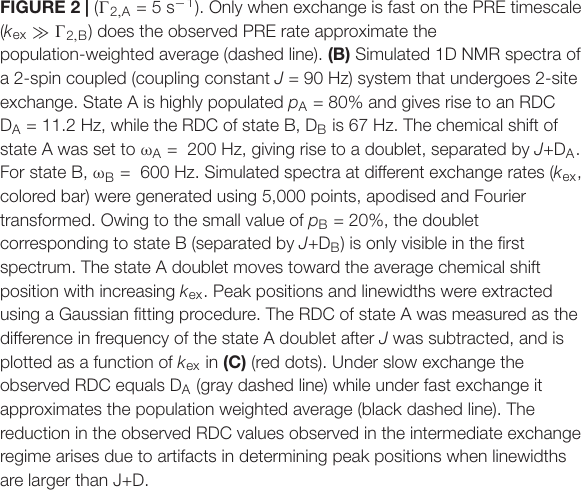
FIGURE 2 | ( (cid:48) 2 , A = 5 s − 1 ). Only when exchange is fast on the PRE timescale ( k ex (cid:29) (cid:48) 2 , B ) does the observed PRE rate approximate the population-weighted average (dashed line). (B) Simulated 1D NMR spectra of a 2-spin coupled (coupling constant J = 90 Hz) system that undergoes 2-site exchange. State A is highly populated p A = 80% and gives rise to an RDC D A = 11.2 Hz, while the RDC of state B, D B is 67 Hz. The chemical shift of state A was set to ω A = 200 Hz, giving rise to a doublet, separated by J +D A . For state B, ω B = 600 Hz. Simulated spectra at different exchange rates ( k ex , colored bar) were generated using 5,000 points, apodised and Fourier transformed. Owing to the small value of p B = 20%, the doublet corresponding to state B (separated by J +D B ) is only visible in the first spectrum. The state A doublet moves toward the average chemical shift position with increasing k ex . Peak positions and linewidths were extracted using a Gaussian fitting procedure. The RDC of state A was measured as the difference in frequency of the state A doublet after J was subtracted, and is plotted as a function of k ex in (C) (red dots). Under slow exchange the observed RDC equals D A (gray dashed line) while under fast exchange it approximates the population weighted average (black dashed line). The reduction in the observed RDC values observed in the intermediate exchange regime arises due to artifacts in determining peak positions when linewidths are larger than